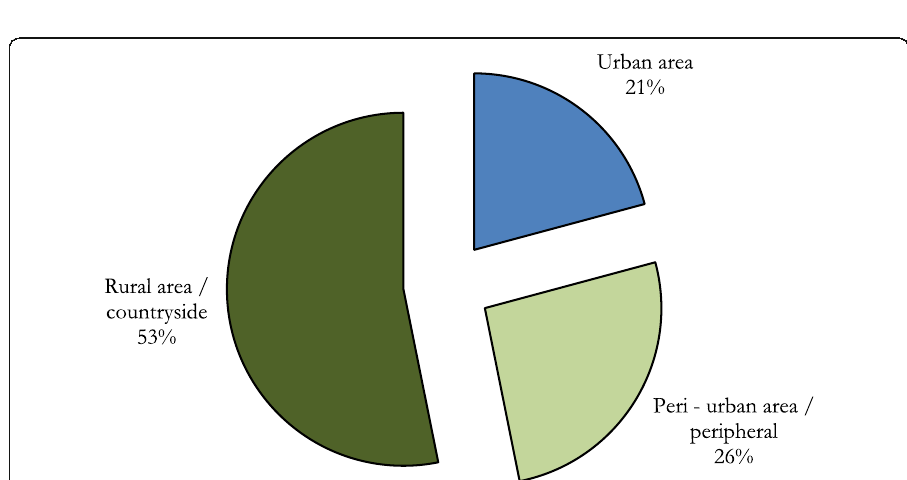
Fig. 2 Sample distribution according to the typology of geographical residence area. Source: our processing of data collected through quantitative survey